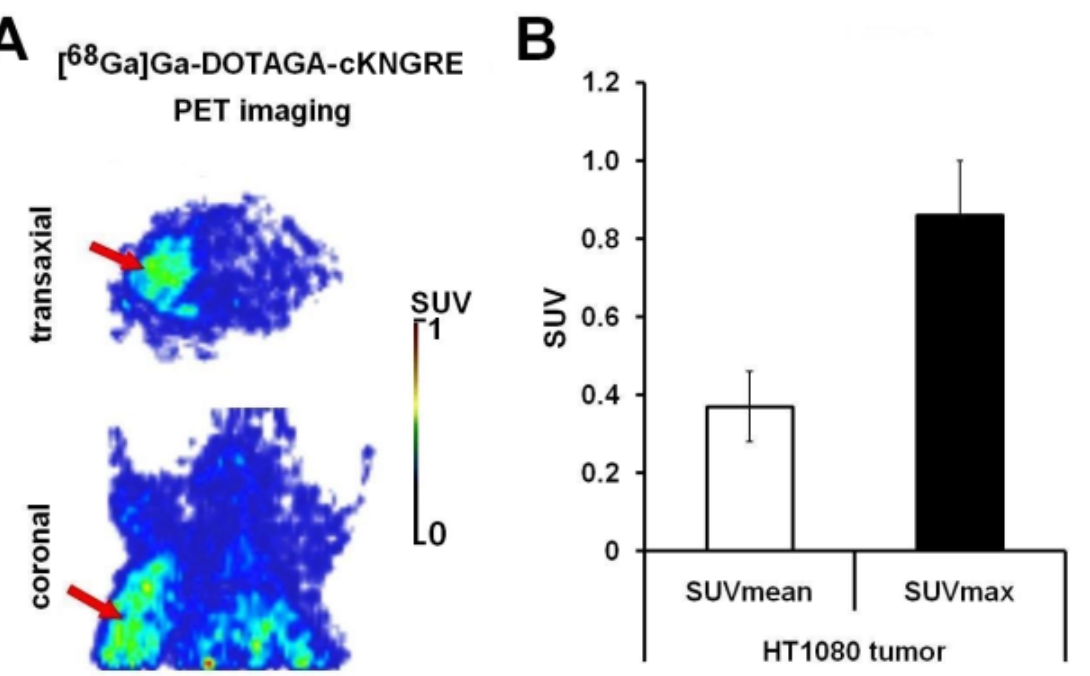
Figure 2. In vivo assessment of 68 Ga-labelled DOTAGA-conjugated cKNGRE ([ 68 Ga]Ga-DOTAGA- cKNGRE) uptake in HT1080 tumour-bearing CB17 SCID mice. ( A ) demonstrates the representative decay-corrected transaxial and coronal PET images of the tumourous study mice 90 min after the intravenous injection of [ 68 Ga]Ga-DOTAGA-cKNGRE, 10 ± 1 days after subcutaneous tumour gener- ation ( A ). ( B ) represents the quantitative SUV analyses of the radiotracer uptake of the HT1080 tu- mours (n = 5) 90 min post tracer administration and 10 ± 1 days after the subcutaneous injection of HT1080 tumour cells. SUV data are presented as mean ± SD. Red arrows: HT1080 tumour. 68 Ga: gallium-68; DOTAGA: 1,4,7,10-tetrakis(carboxymethyl)-1,4,7,10-tetraazacyclododecane glutaric acid; cKNGRE: cyclic Lysine–Asparagine–Glycine–Arginine–Glutamic acid; SCID: severe combined im- munodeficient; PET: positron emission tomography; SUV: standardised uptake value; SD: standard